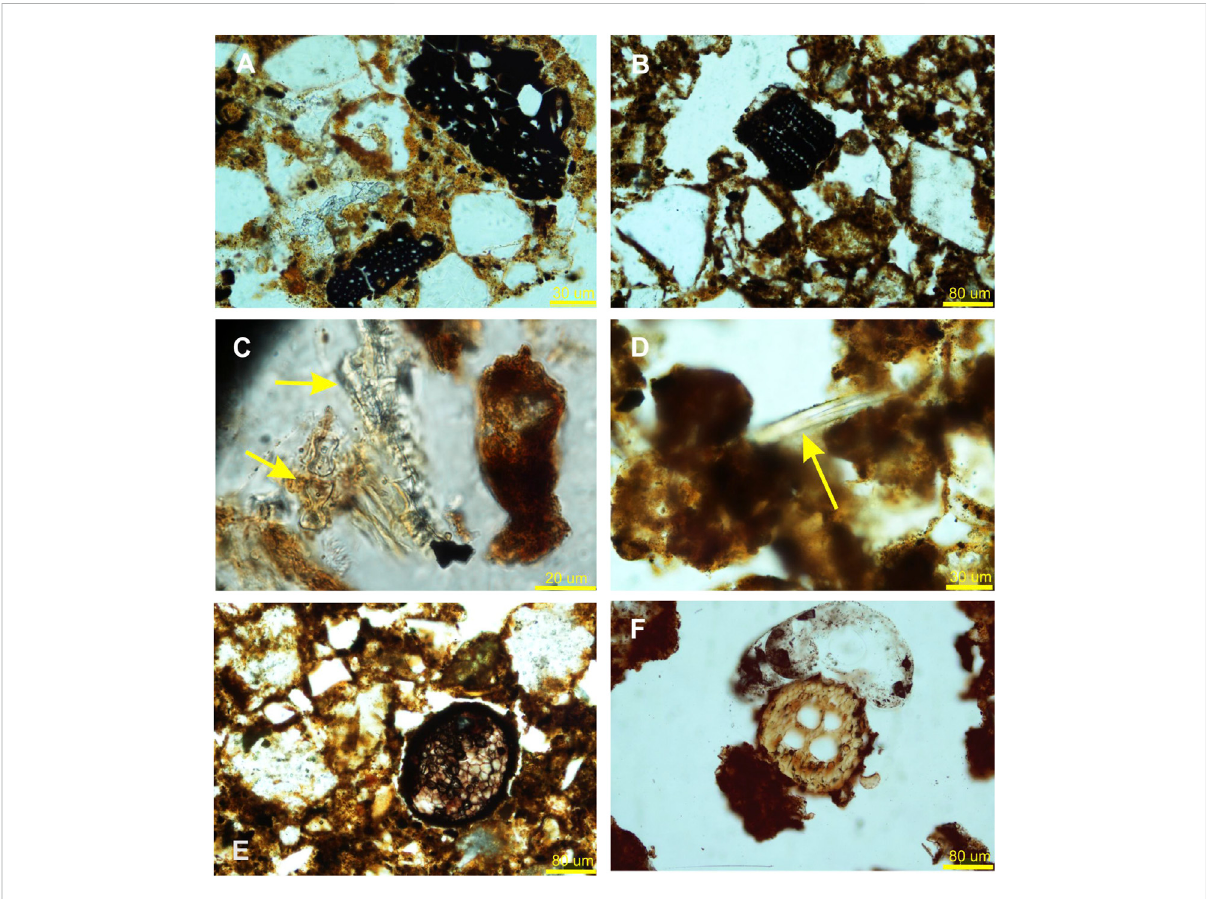
FIGURE 9 Micropictographs of plant remains in the Old Geos pro fi le, including (A) degraded charcoal fragments, (B) vesicular charcoal fragment, (C) dumbbell-shaped wood phytolith, (D) sponge spicule, cut parallel to axial canal, (E) fungal spore, and (F) possible fungal